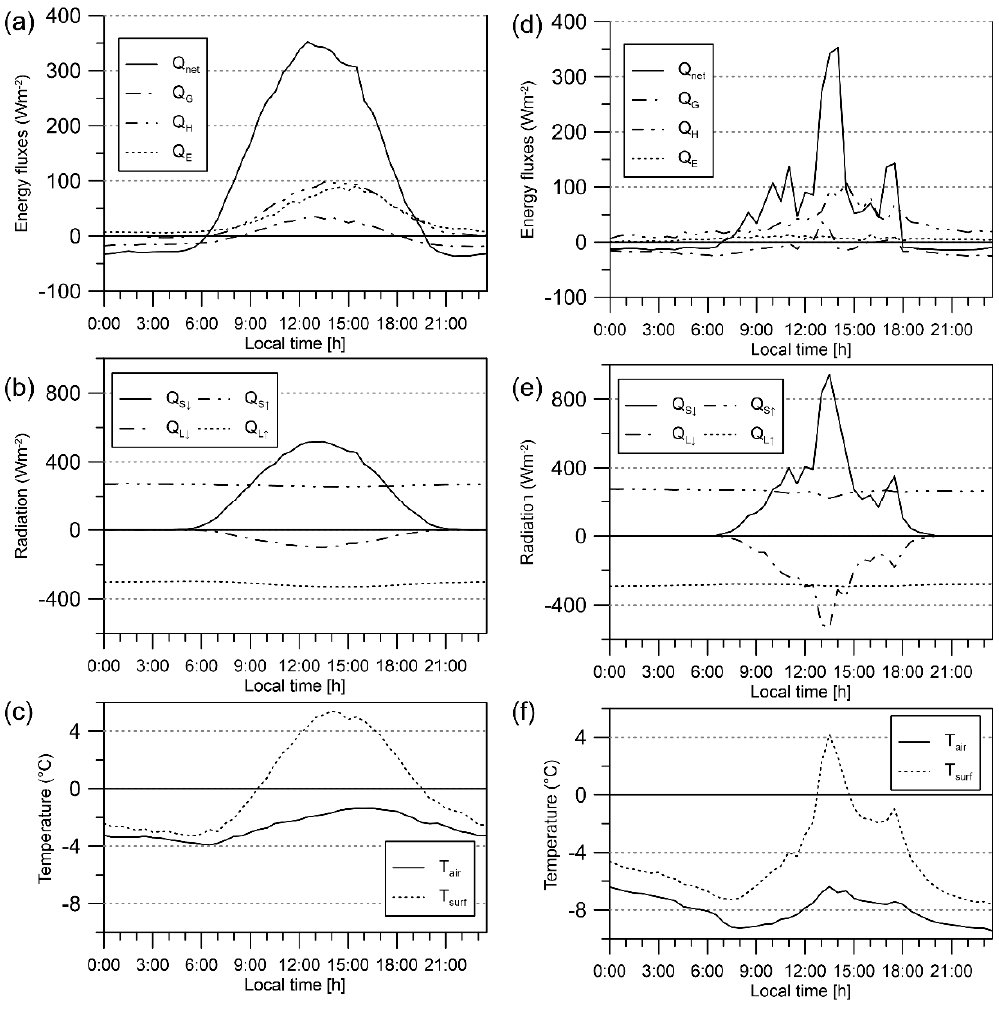
Figure 5. Daily regimes of surface energy budget components on James Ross Island between 23 January and 21 March 2018: averaged day (left column) and day with snow cover (right column, 4 March). ( a , d ): net radiation (Q net ), ground heat flux (Q G ), sensible heat flux (Q H ) and latent heat flux (Q E ). ( b , e ): incoming shortwave radiation (Q S ↓ ), outgoing shortwave radiation (Q S ↑ ), incoming longwave radiation (Q L ↓ ) and outgoing longwave radiation (Q L ↑ ). ( c , f ): air temperature (T air ) and ground surface temperature (T surf ).